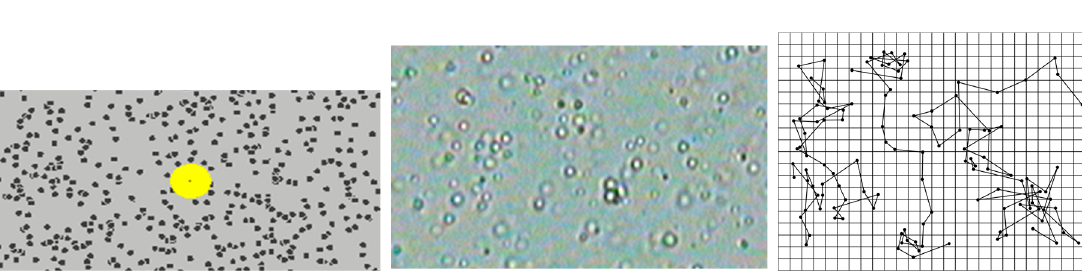
Figure 2. ( Left ) Illustration of Brownian motion. A pollen grain (central circle, yellow) embedded in water (water molecules represented as tiny black dots). ( Center ) Confocal image of a colloidal solution. Colloidal particles are subjected to Brownian motion in water solution (grey background). Water molecules are unobservable. ( Right ) Trajectories drawn by Perrin in his original experiments on latex particles a century ago. By measuring the mean squared displacement from the data it is then possible to extract the diffusion constant D. From the water viscosity η and the expression for the friction coe ffi cient γ = 6 π R η (sphere case) one can extract the value of the Boltzmann constant k B . From there the Avogadro number follows: N A = R / k B with R the ideal gas constant.